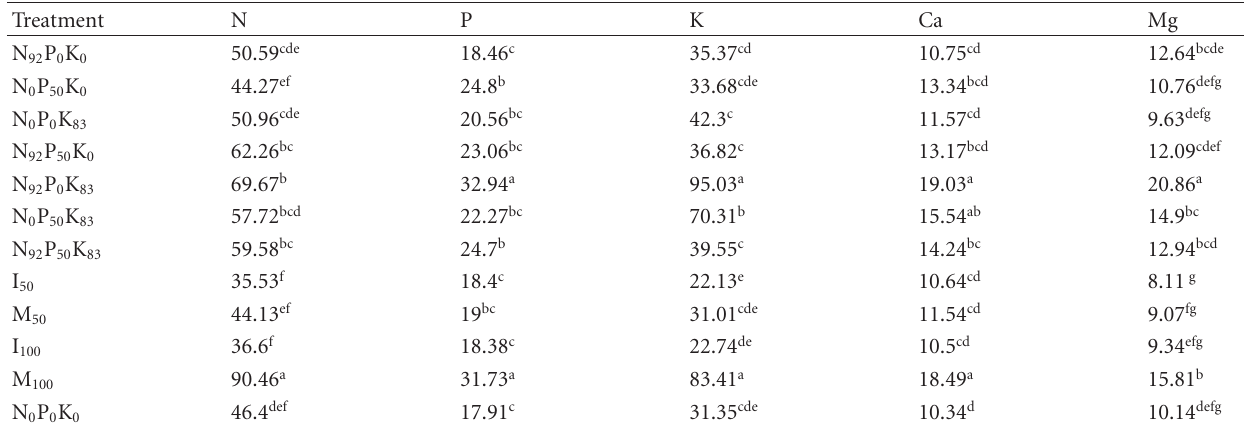
Table 4: Nutrient uptakes for shoot at harvest (Kg/ha).